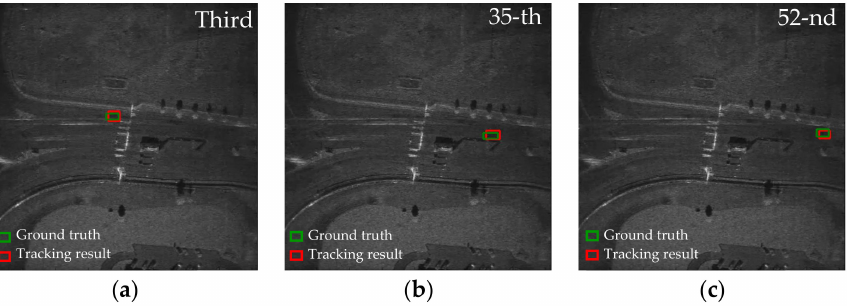
Figure 18. Tracking results of the real Video-SAR data: ( a ) third frame in Video 2; ( b ) 35th frame in Video 2; ( c ) 52nd frame in Video